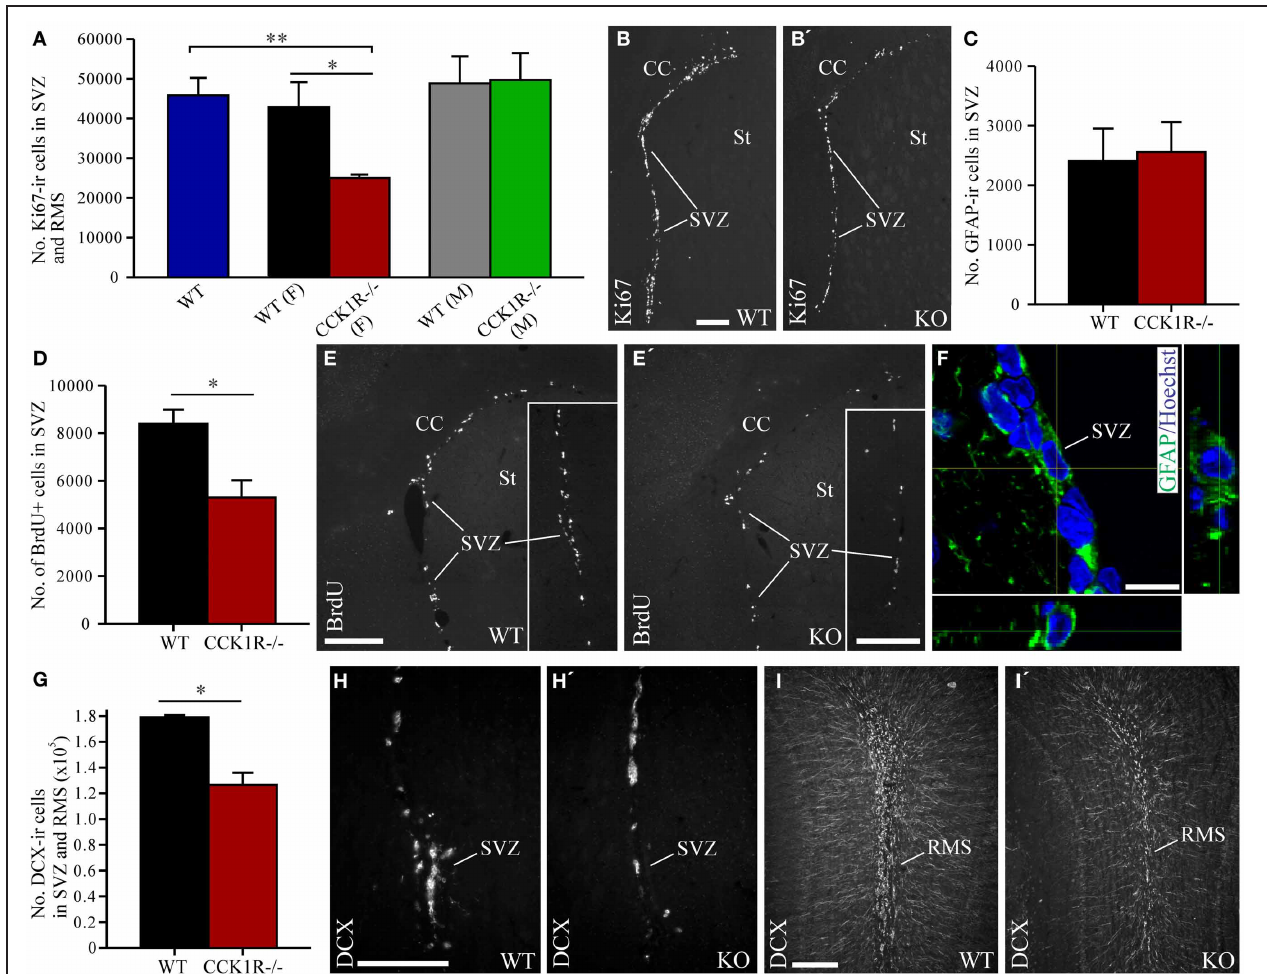
FIGURE 2 | Estimates of proliferating cells, neuroblasts, and astrocytes in the SVZ and RMS of CCK1R − / − and wild-type mice. (A,B) Estimated number of Ki67-ir cell bodies in the SVZ and RMS of CCK1R − / − and wild-type mice (A) . In (A) WT blue bar = wild-type (male and female combined, n = 8); WT (F) black bar = female wild-type ( n = 4); CCK1R − / − (F) red bar = female CCK1R − / − ( n = 4); WT (M) grey bar = male wild-type ( n = 4); and CCK1R − / − (M) green bar = male CCK1R − / − ( n = 4). Photomicrographs of Ki67-LI in the SVZ of female (B) wild-type and (B (cid:3) ) CCK1R − / − mice. (D,E) Estimated number of BrdU + cell bodies in the SVZ of female CCK1R − / − and wild-type mice (D) (see Protocol 1 , Figure 1A ). Photomicrographs of BrdU-LI in the SVZ of female (E) wild-type and (E (cid:3) ) CCK1R − / − mice. (C,F) Estimated number of GFAP-ir astrocytes in the SVZ of female wild-type and CCK1R − / − mice (C) . Double-immunofluorescence confocal